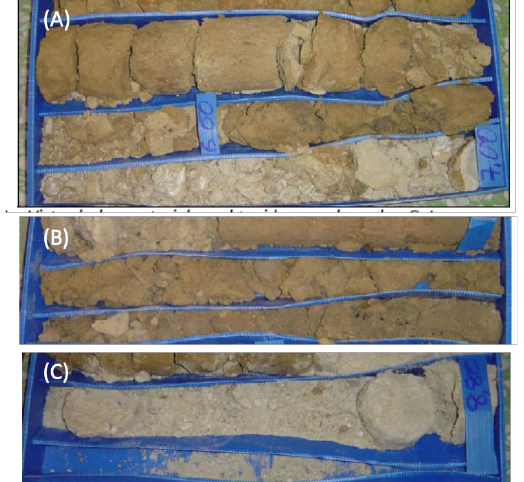
Figure 7. View of the units obtained in boreholes drilled: (A) Gypsiferous silts (glacis); (B) Clay with gypsum (altered bedrock); (C) Gypsum bedrock (Zaragoza Gypsum Formation).